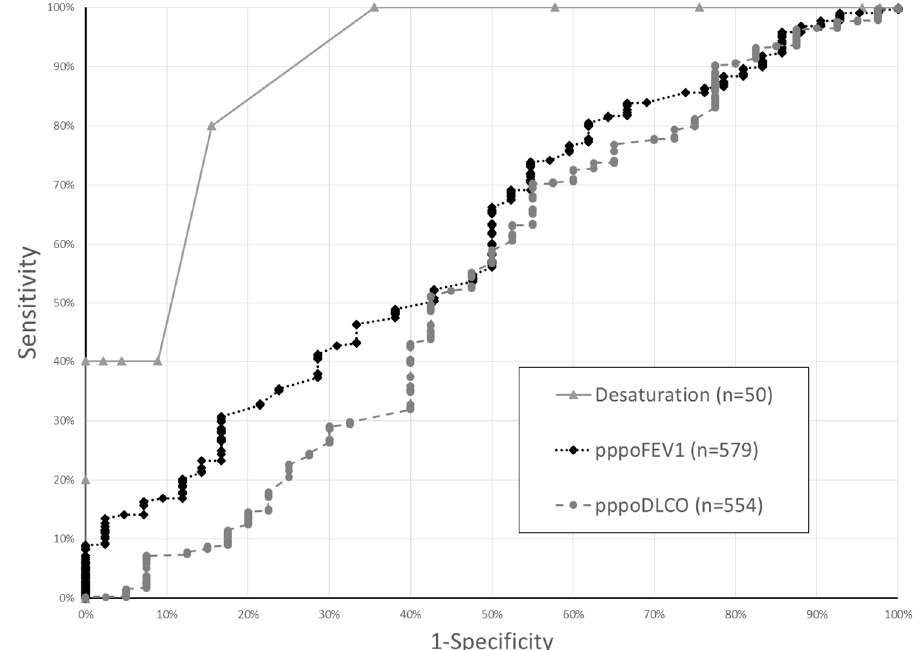
Figure 1. Receiver operating characteristic curves for amount of desaturation during six-minute walk and pulmonary function test results to detect major morbidity among 581 patients with pppoFEV1 or pppoDLCO values less ≤ 60%. For a given test, each data point represents a result of that test and its associated sensitivity and specificity. The area under the curve is a measure of test accuracy.